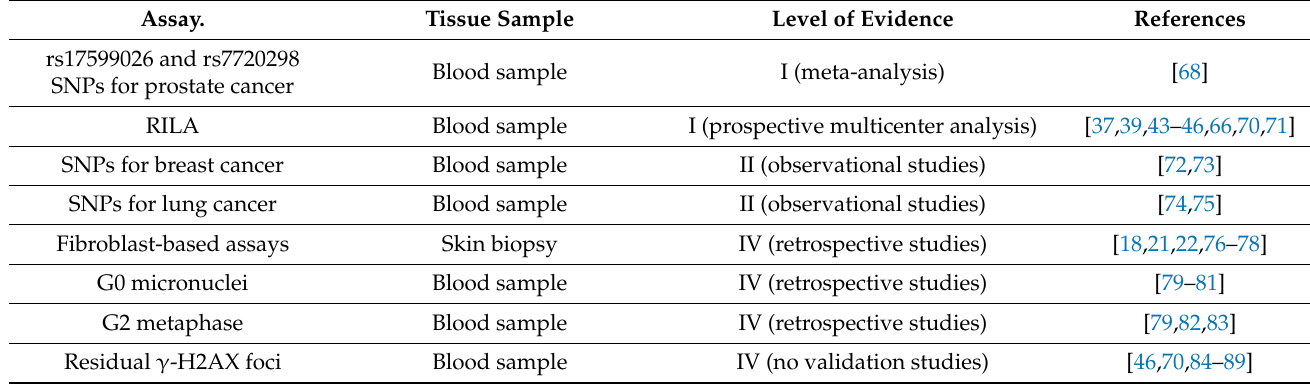
Table 2. Available radiosensitivity assays with their respective level of evidence (based on